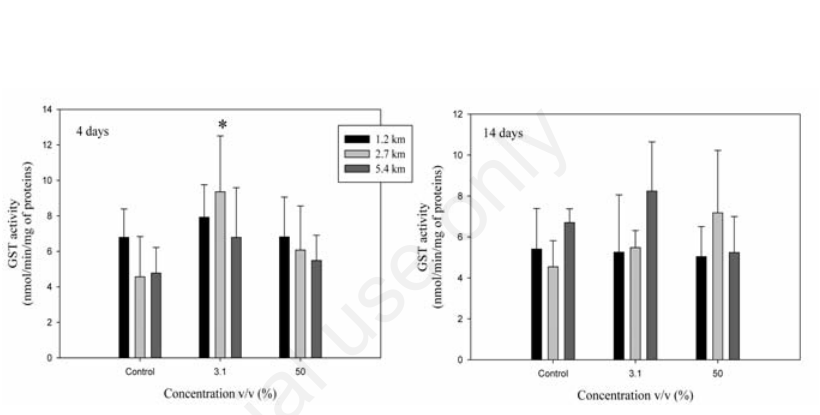
Figure 3. Gluthatione S-transferase activity in trout liver after 4 and 14 days exposure to groundwater at 1.2 km, 2.7 km and 5.4 km. Data are presented as mean±standard error. Asterisks indicate significant difference from controls (*P